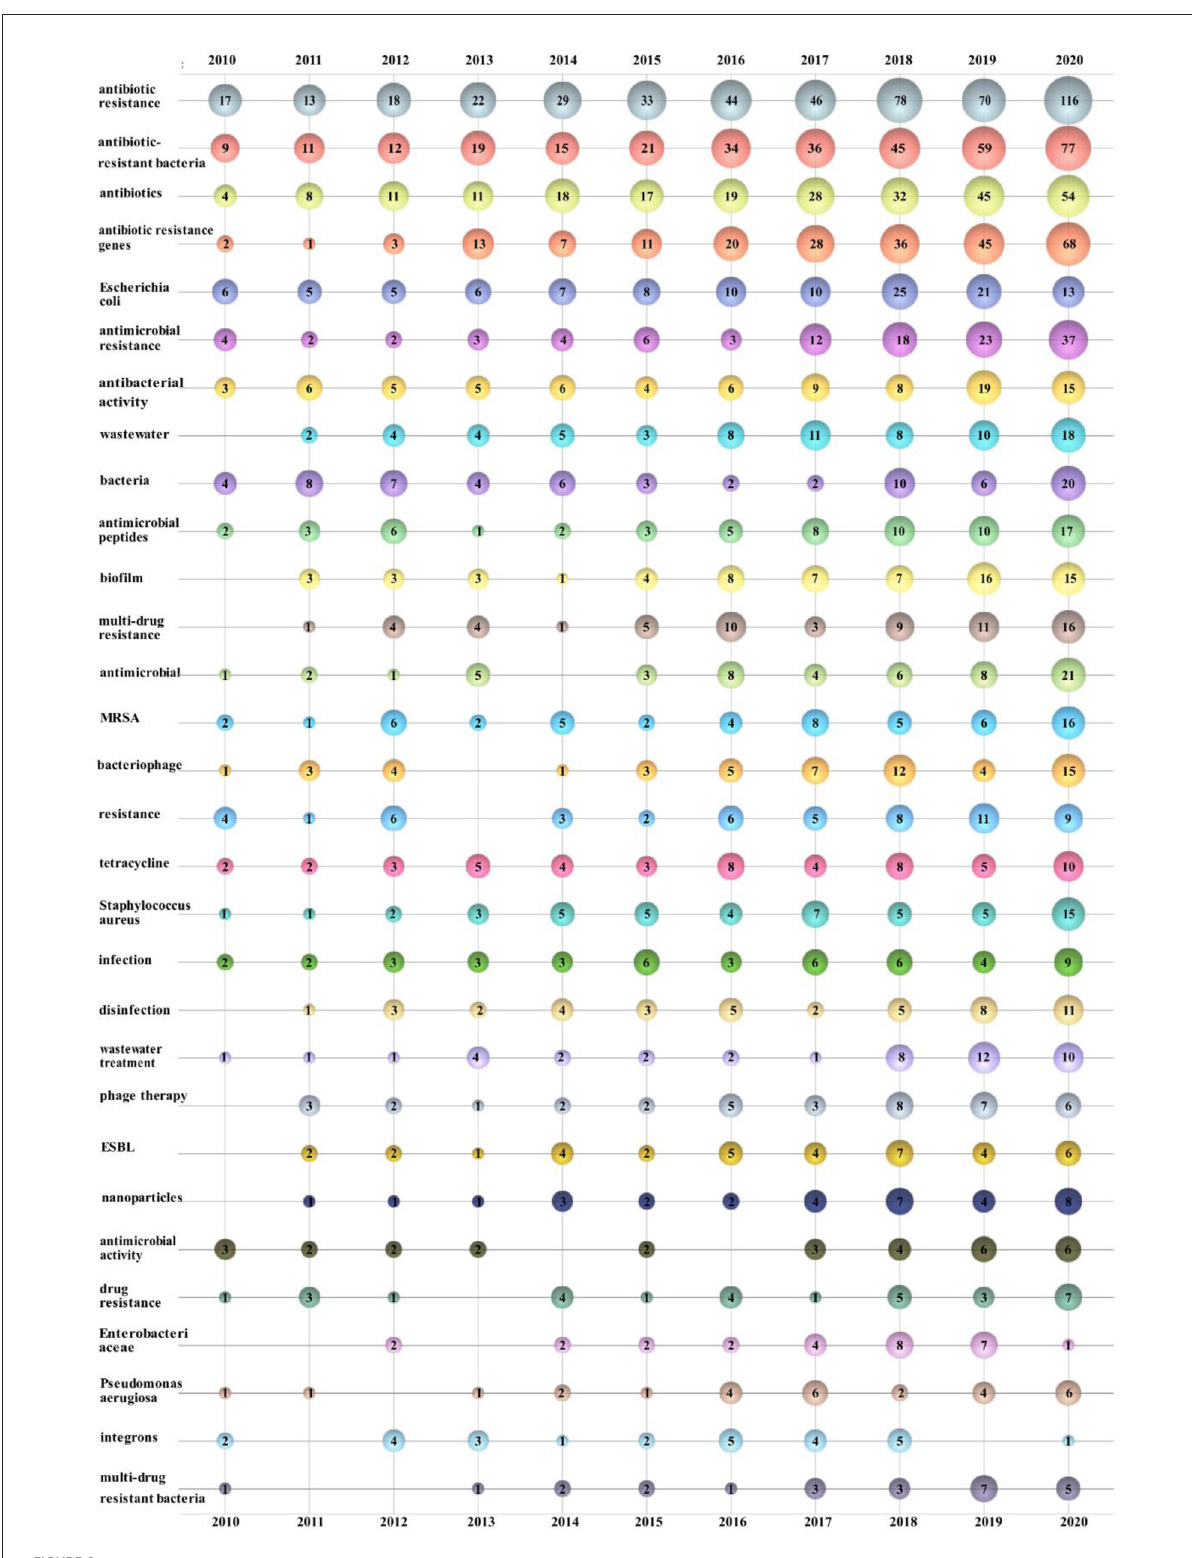
FIGURE6 Bubble chart of the top 30 author keywords by